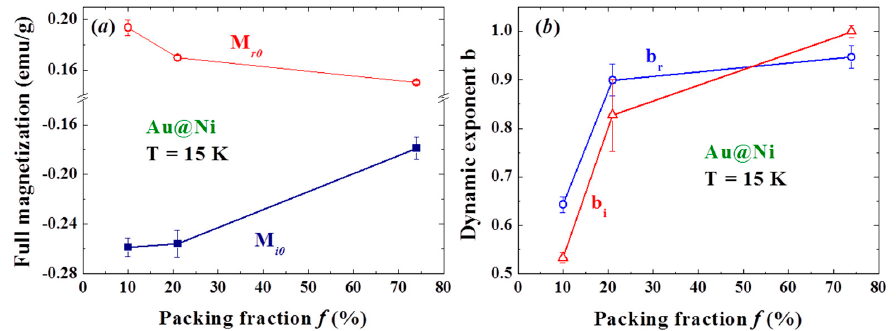
Figure 10. Variations of ( a ) full induced magnetization M i0 and full residual magnetization M r0 ; and ( b ) dynamic exponents b i and b r with the packing fraction of the NP assembly.